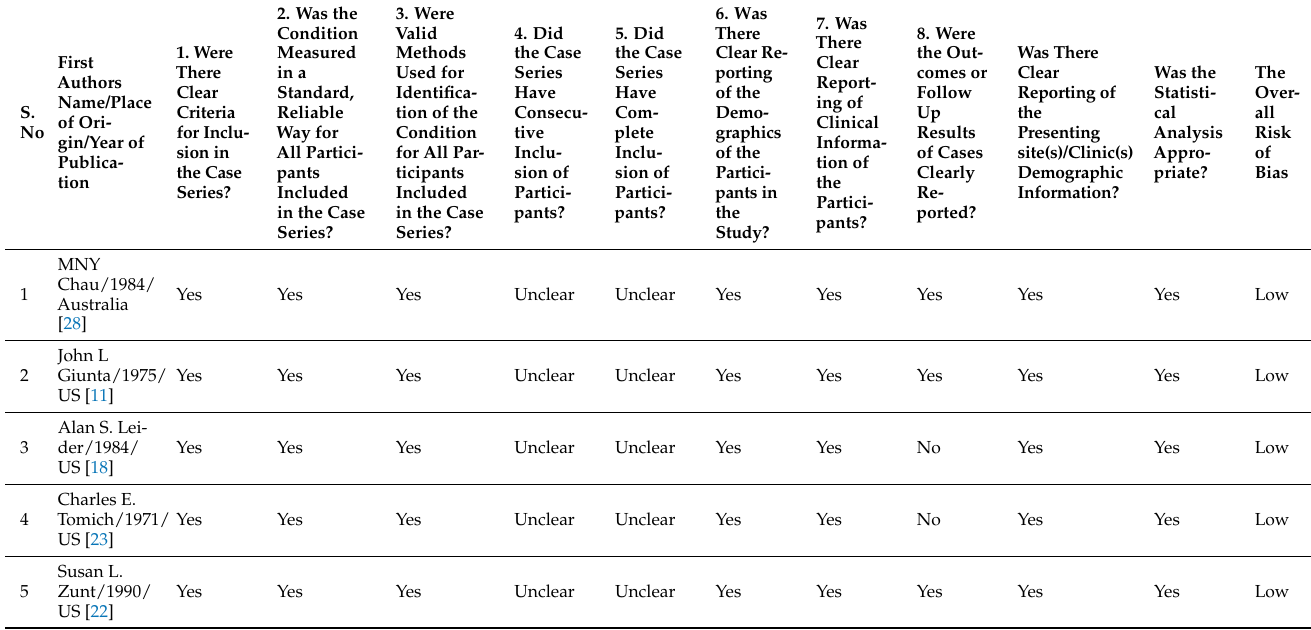
Table 3. Risk of bias evaluation of the included studies - The Joanna Briggs institute critical appraisal checklist for case